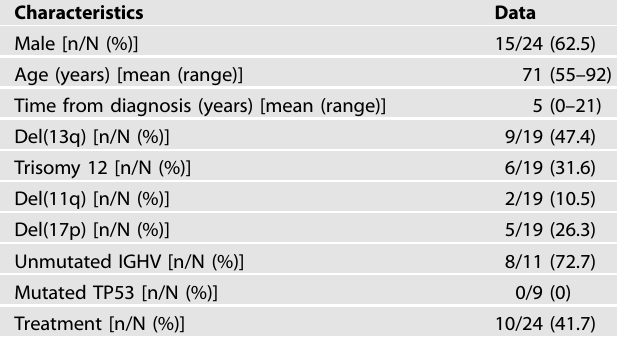
Table 1. Clinical characteristics of the patients with